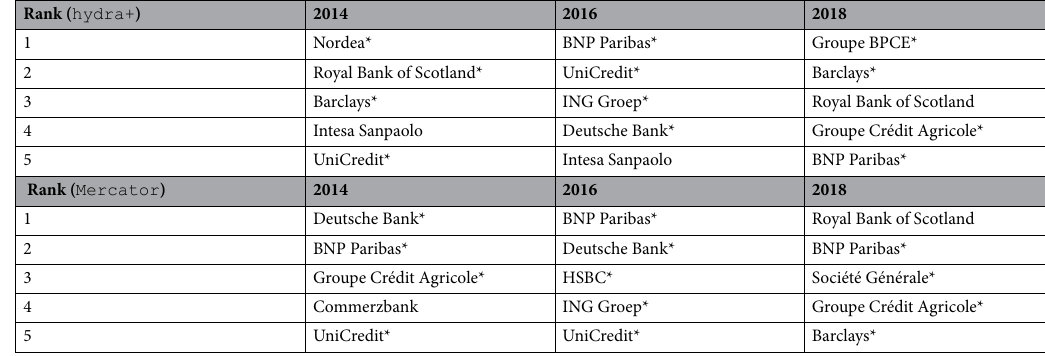
Table 2. For each year the five banks with the highest hyperbolic centrality (i.e., smallest r coordinate) are listed. The upper subtable corresponds to the hydra+ embedding of the full network and the lower subtable to the Mercator embedding of its 25%-backbone. Asterisks denote banks that are considered globally systemic relevant institutions (G-SIBs).